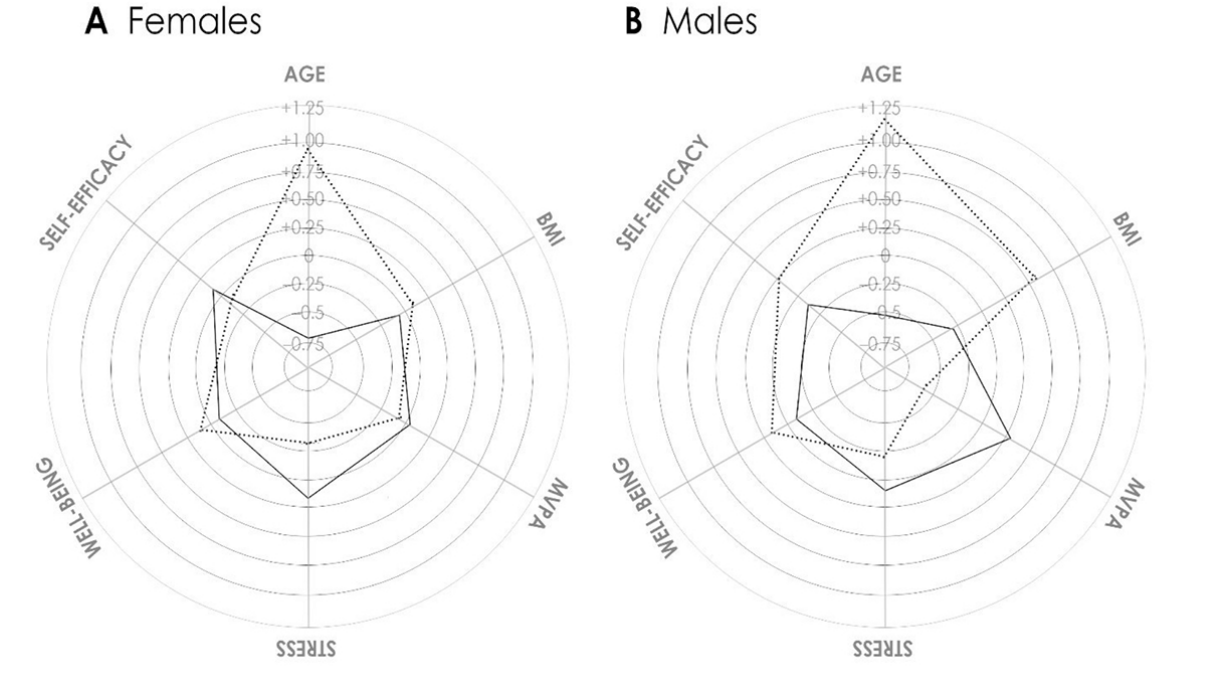
Figure 1. Radar graphs of the female and male cluster solution. BMI: body mass index, MVPA: moderate and vigorous physical